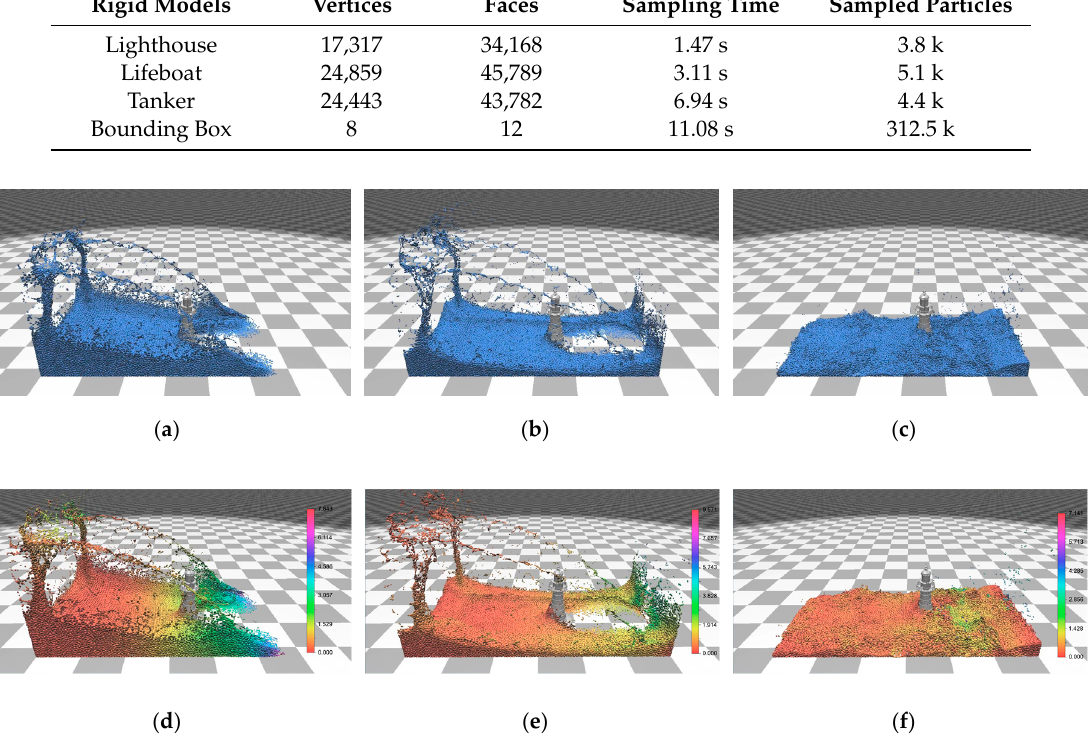
Figure 7. Design drawing of waves crashing against the lighthouse. The front and side view show the detailed parameters of the bounding box, lighthouse, and fluid block. In the side view, the lighthouse is located behind the fluid block, thus the lighthouse is represented by dashed lines.